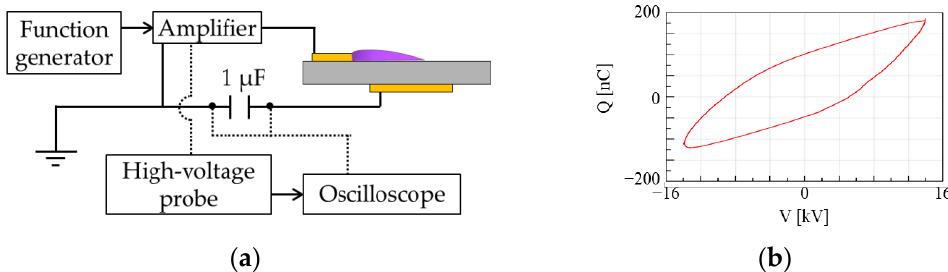
Figure 3. Power supply system of the PA: ( a ) schematic of the high-voltage supply and consumption power measuring system; ( b ) Q – V Lissajous curve, obtained from the charge Q and applied voltage V, in the case of 28 kV pp and 1 kHz.